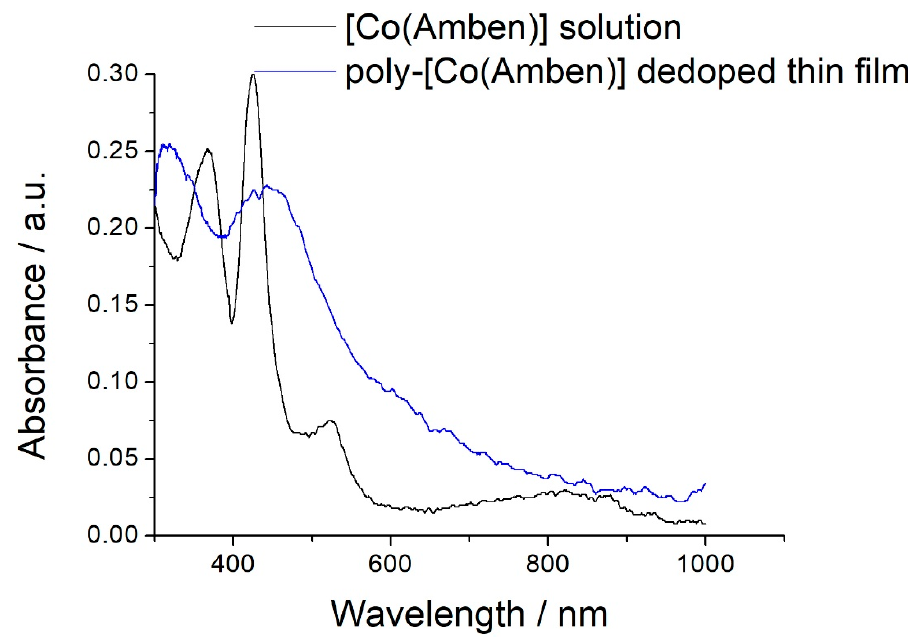
Figure 5. UV-vis-NIR spectra of 0.33*10 –4 M [Co(Amben)] solution (black curve) and poly-[Co(Amben)] polymer film in the neutral (de-doped) state (blue curve). UV-vis-NIR spectra of the doped poly-[Co(Amben)] film were collected at fixed potentials, incrementally stepped in 0.1 V intervals from − 0.9 to +1.0 V and in 0.15 V intervals from +1.0 to +1.3 V (Figure 6).